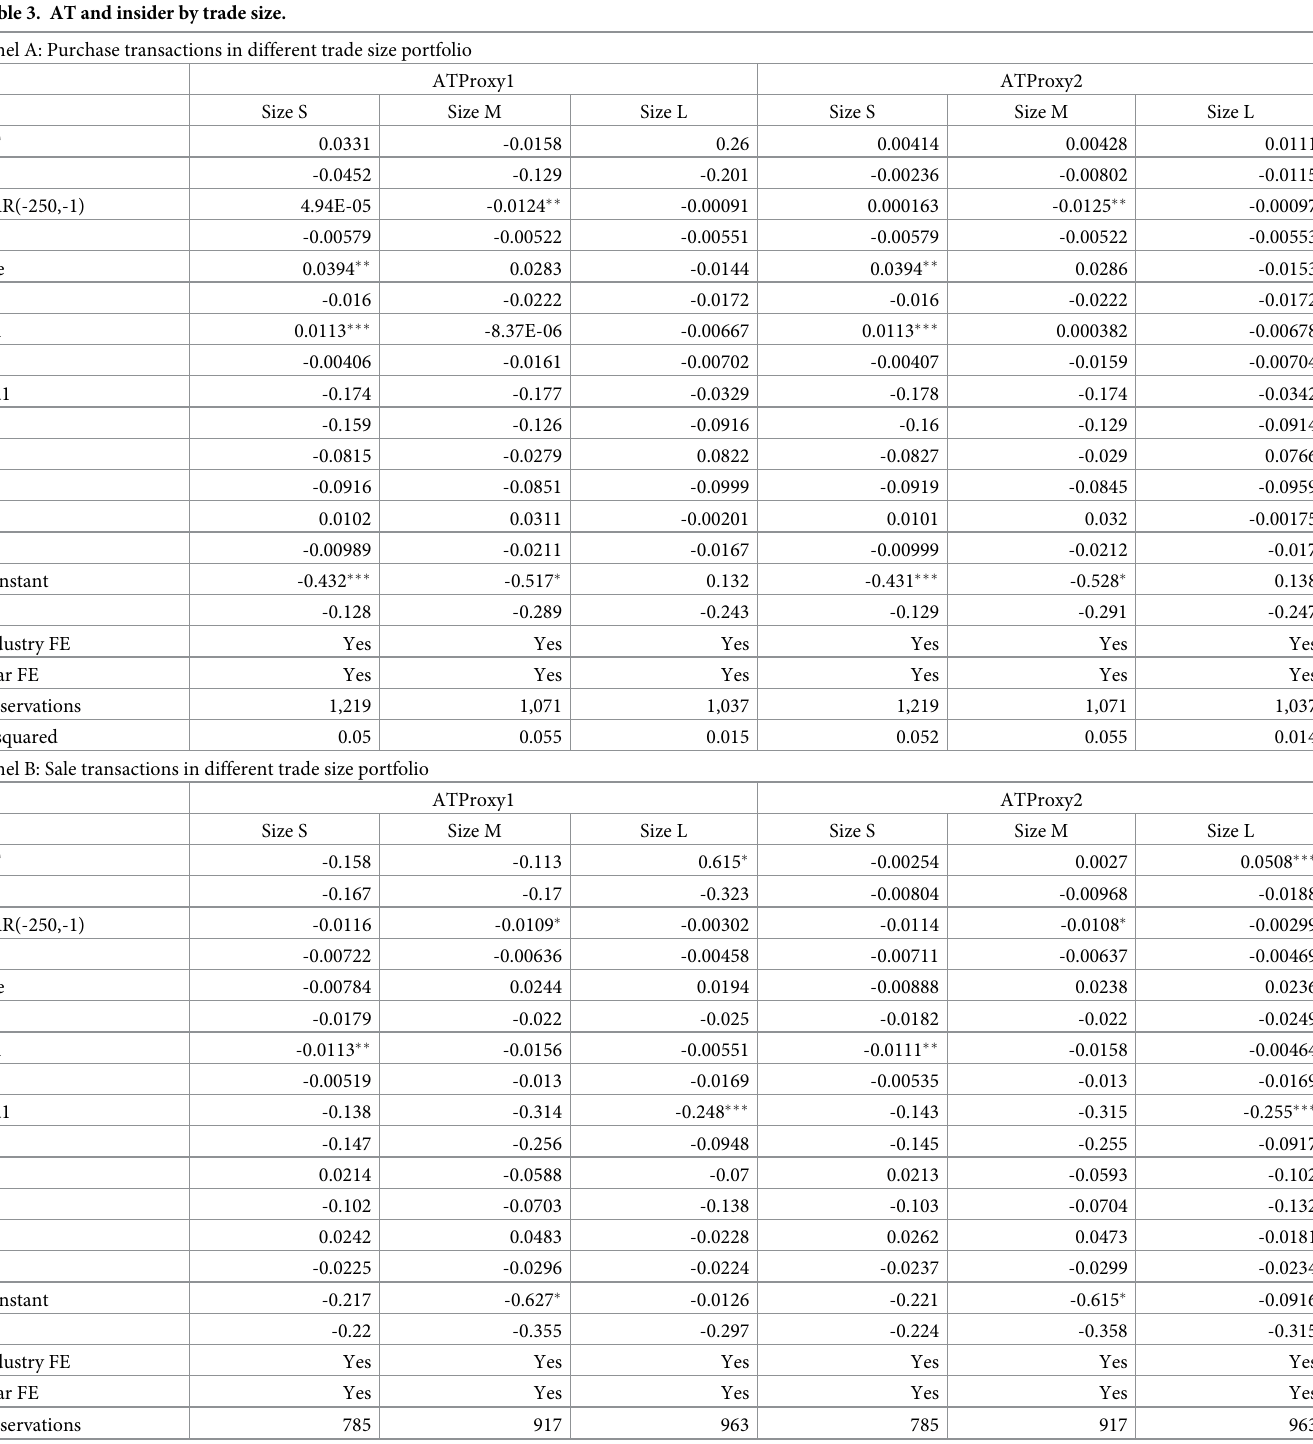
Table 3. AT and insider by trade